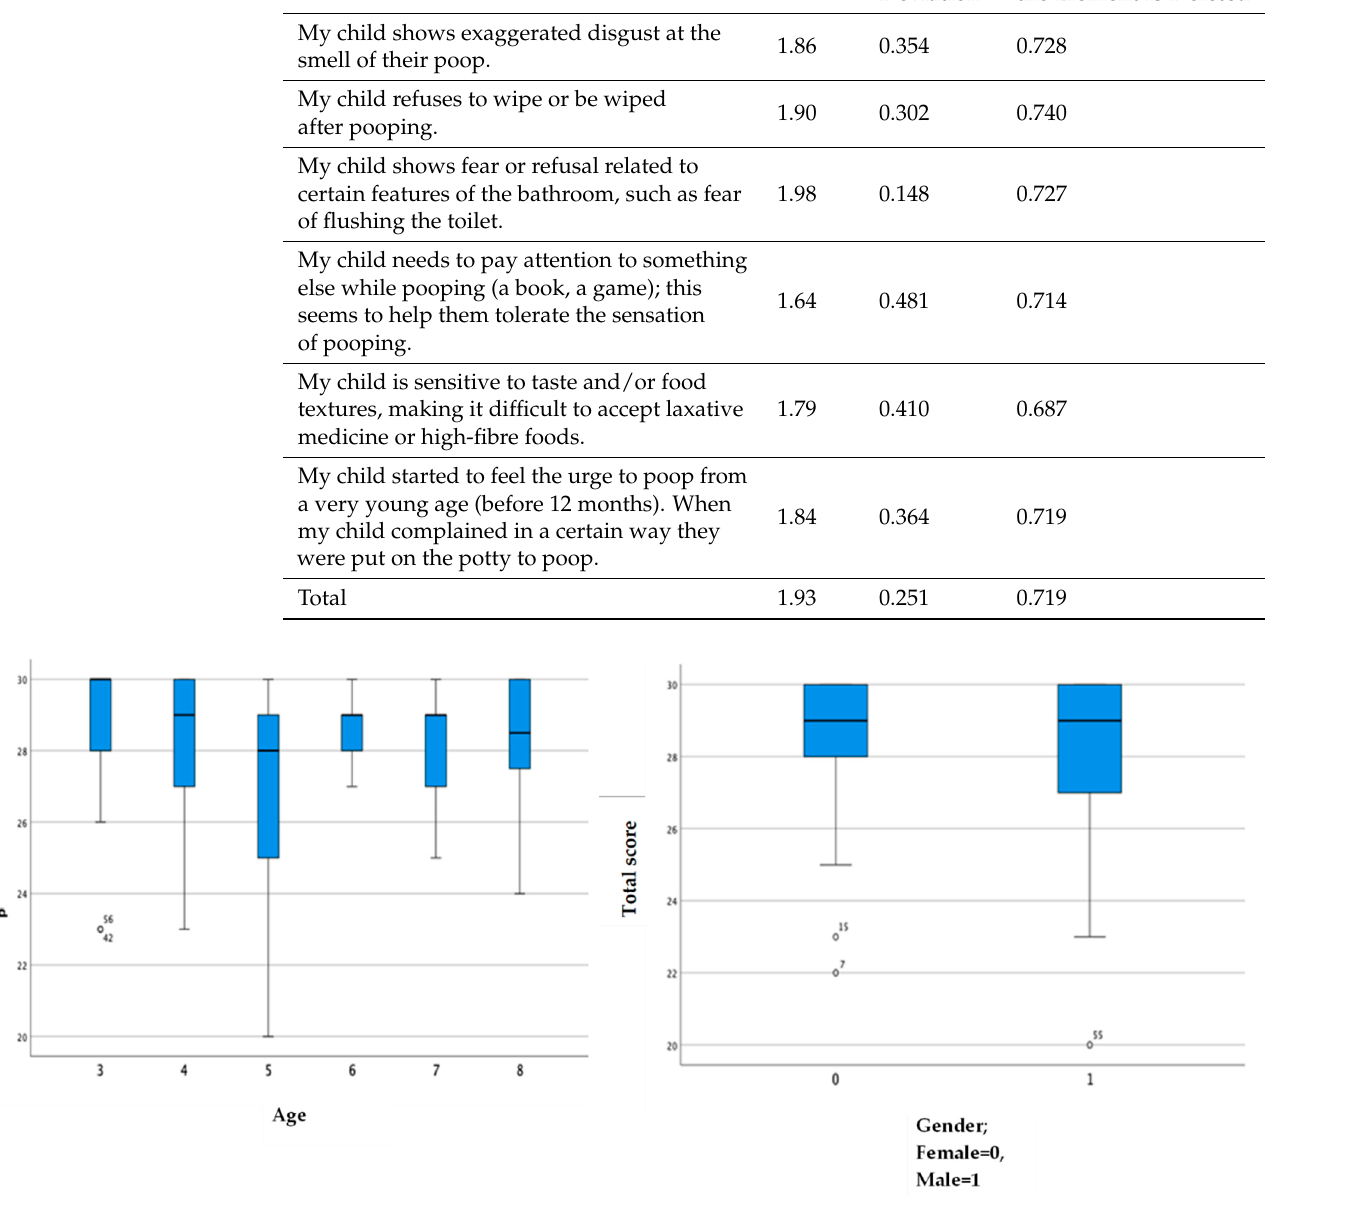
Figure 1. Cross cultural validity: Student’s t -test between and demographic characteristics of participants.